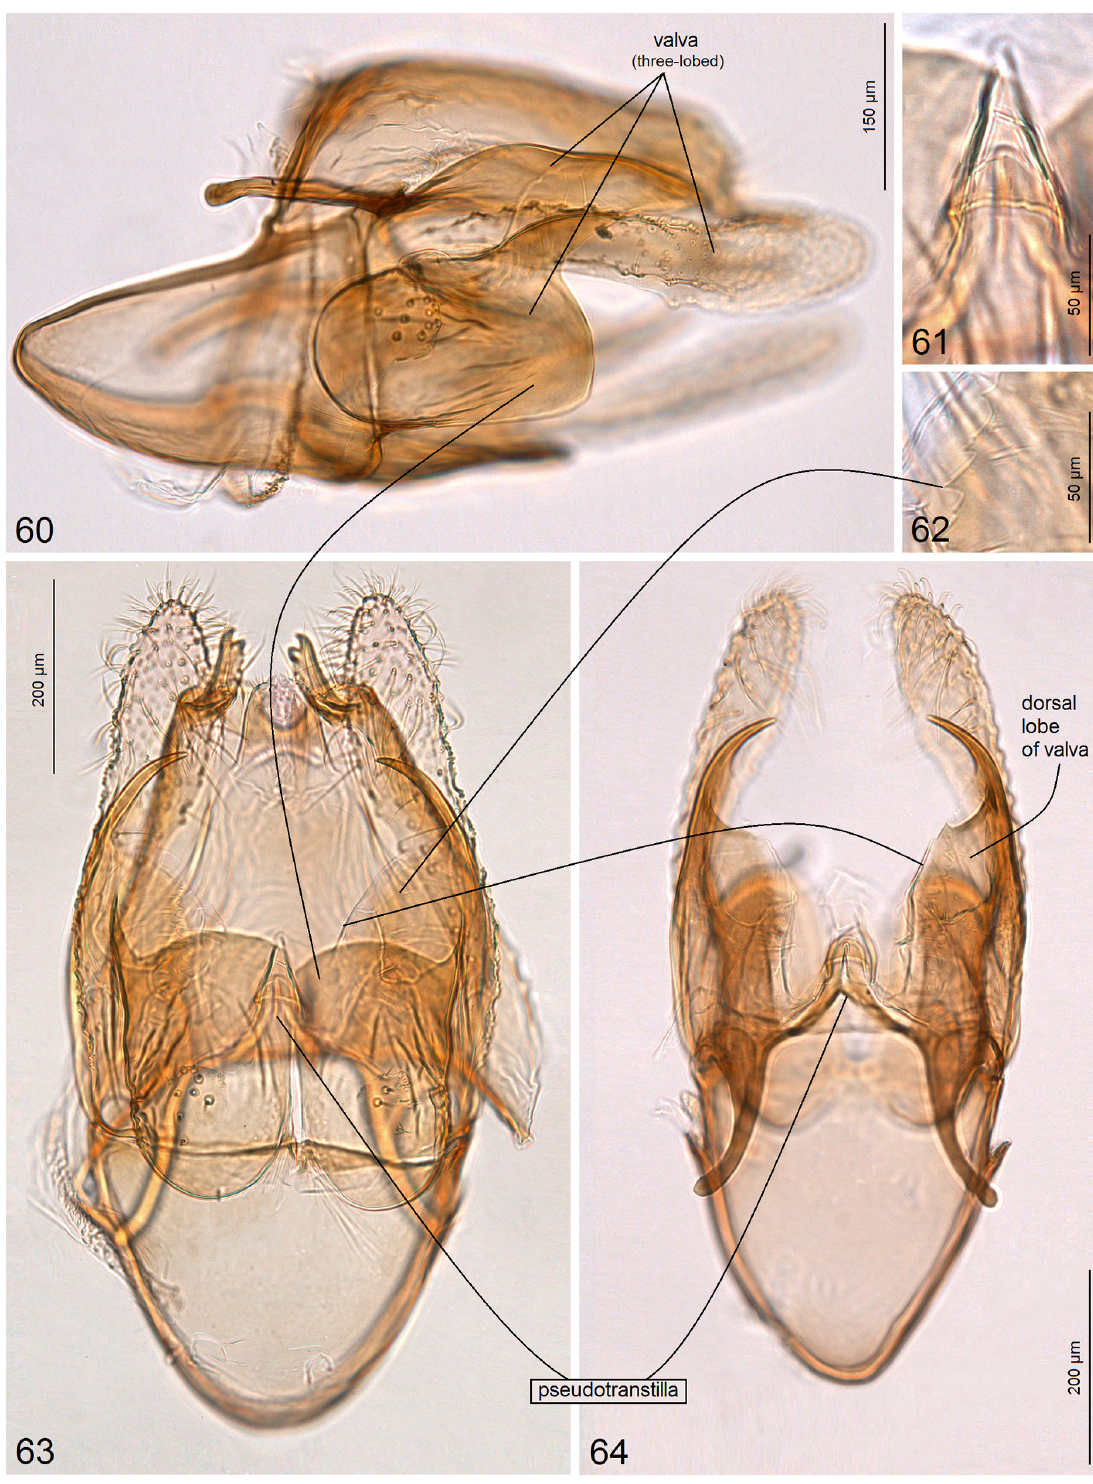
Figs 60–64. Male genitalia of Astrotischeria scutifera Diškus & Stonis sp. nov. (NHMUK). 60 . Lateral view of capsule, with phallus removed, paratype (genitalia slide no. 010316177). 61 . Median element of modified anellus (pseudotranstilla), paratype (genitalia slide no. 010316176). 62 . Same, dentate margin of dorsal lobe of valva. 63 . Same, ventral view of capsule, with phallus removed. 64 . Pseudotranstilla and dorsal lobe of valva, paratype (genitalia slide no.